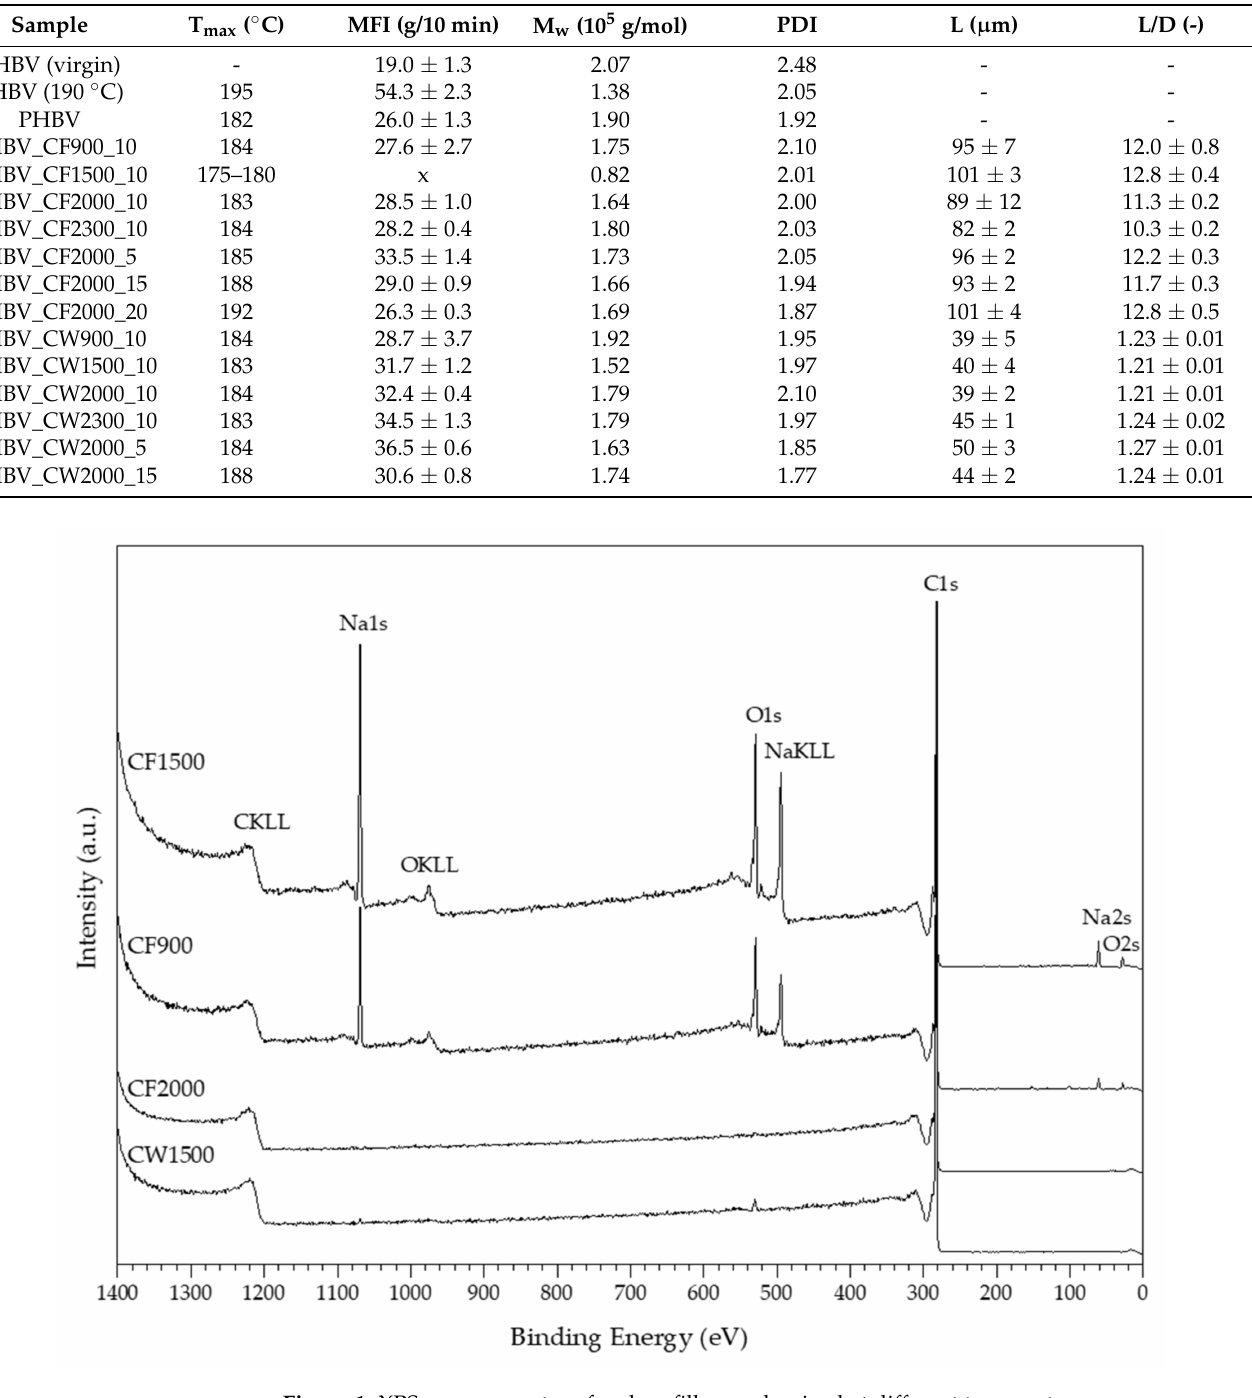
Figure 1. XPS survey spectra of carbon fillers carbonized at different temperatures. As no other significant differences compared to the other fillers were found, we assumed that the extraordinary surface composition of CF1500 might be the reason for the exceptional behavior of the PHBV_CF1500_10